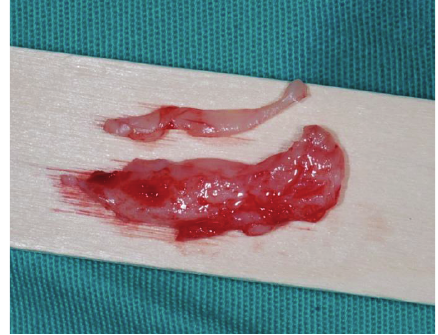
Figure 10: Aspect of the harvested connective tissue graft.